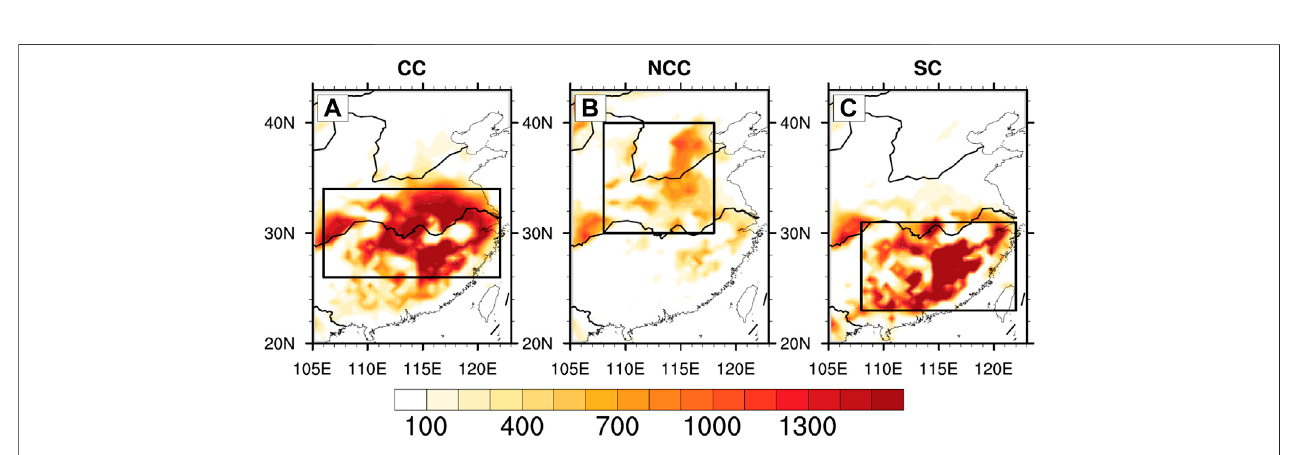
FIGURE 2 | Same as Figure 1 , but for HWCT (unit: °